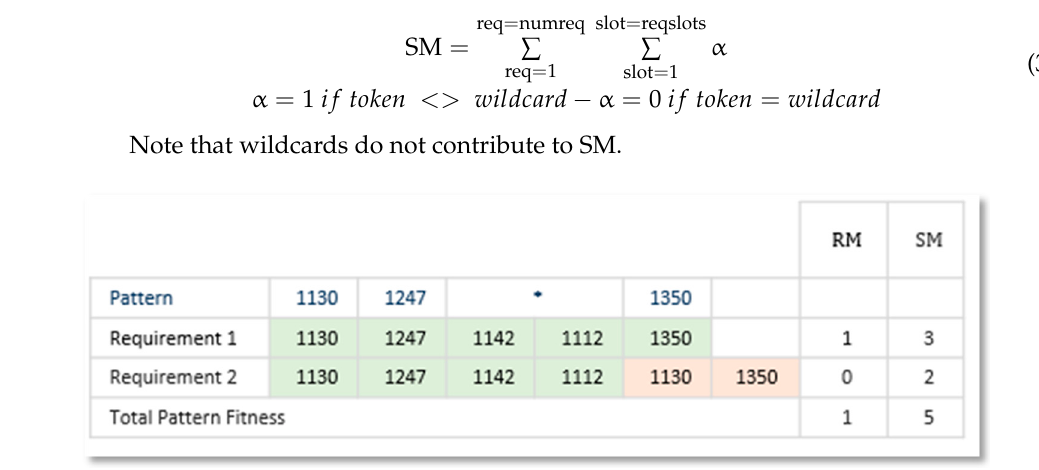
Figure 11. Calculation of Pattern Fitness for a particular RS of 2 requirements (Affinity = 2). Asterisk represents a wildcard token as described in Section 3.1.5.